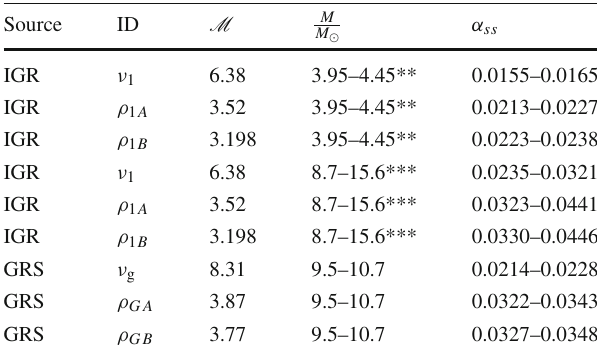
Table 2 Determination of α ss values based on the known IGR and GRS mass values [51–53] and mass- α ss relation presented in the table. *Mass- α ss